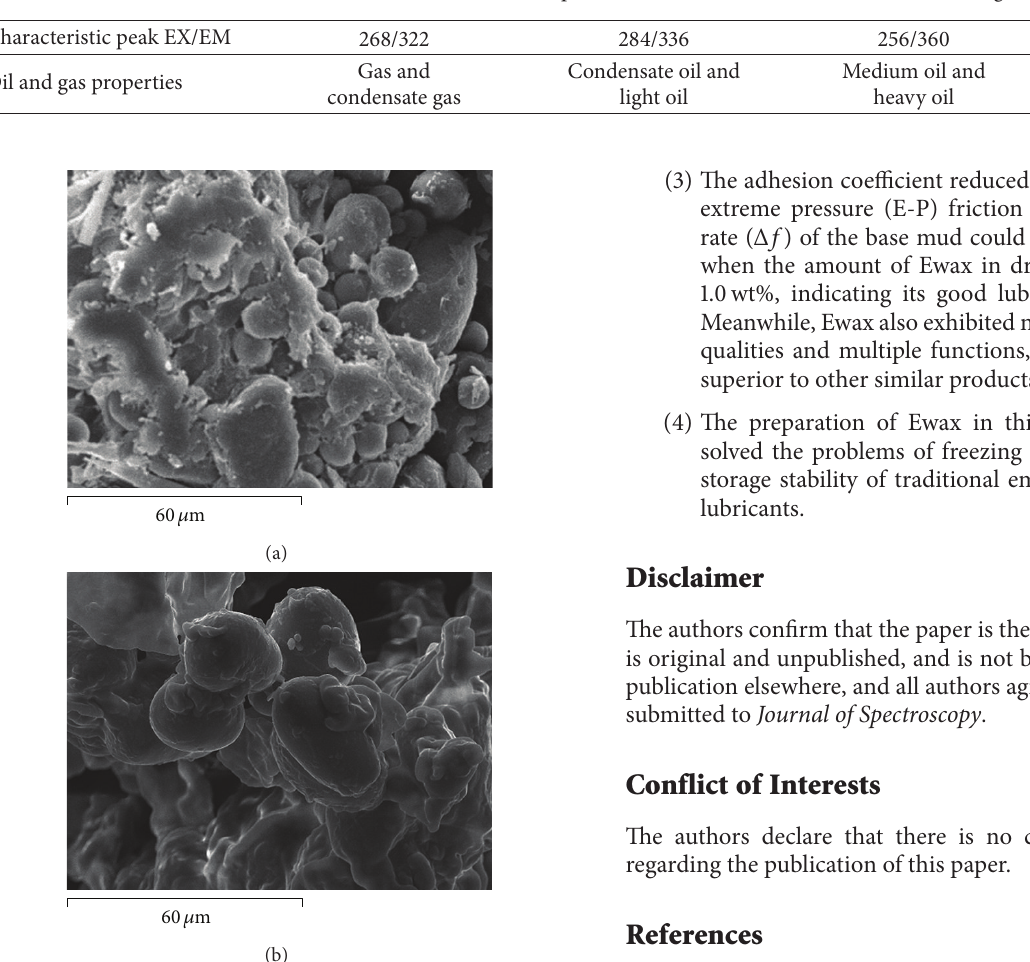
Table 7: Three-dimensional fluorescence spectra features of different crude oil and natural gas.